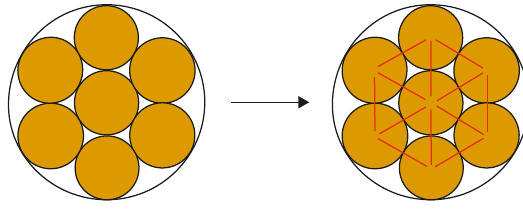
Figure 2: Formation of an agglomerate. Table 1: Parameters of a typical sand grain in DEM.